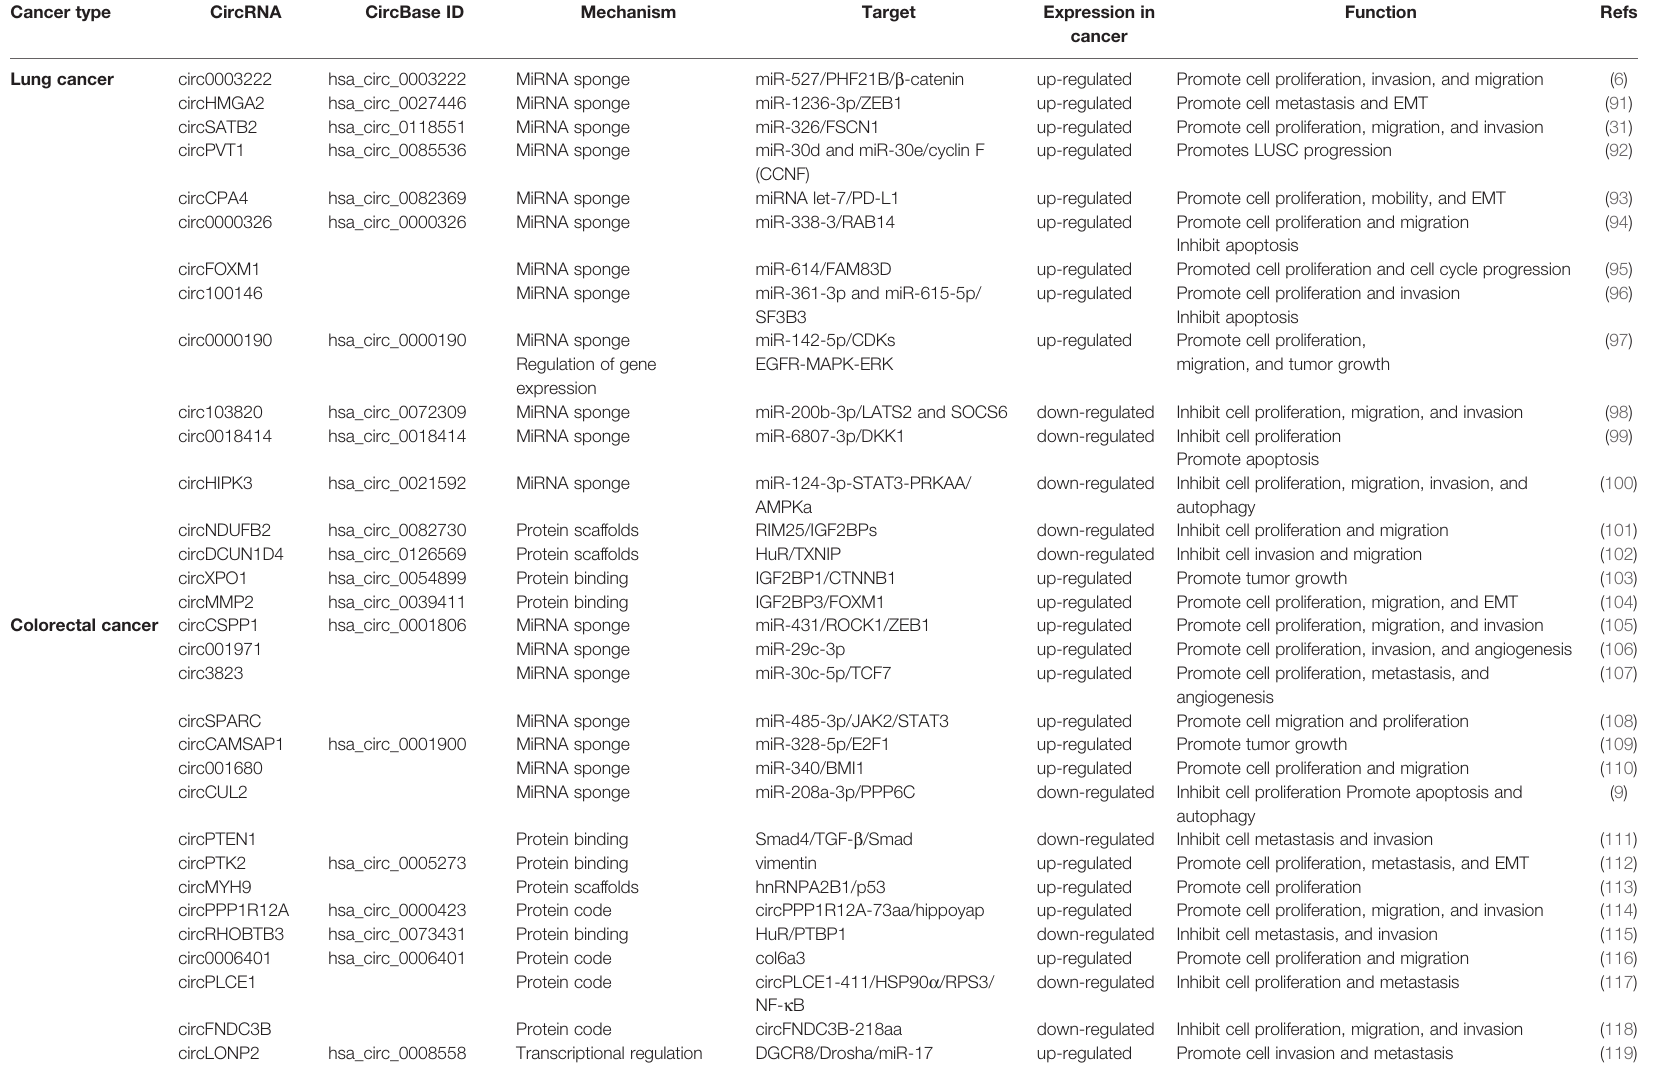
TABLE 3 | Dysregulated circRNAs in common